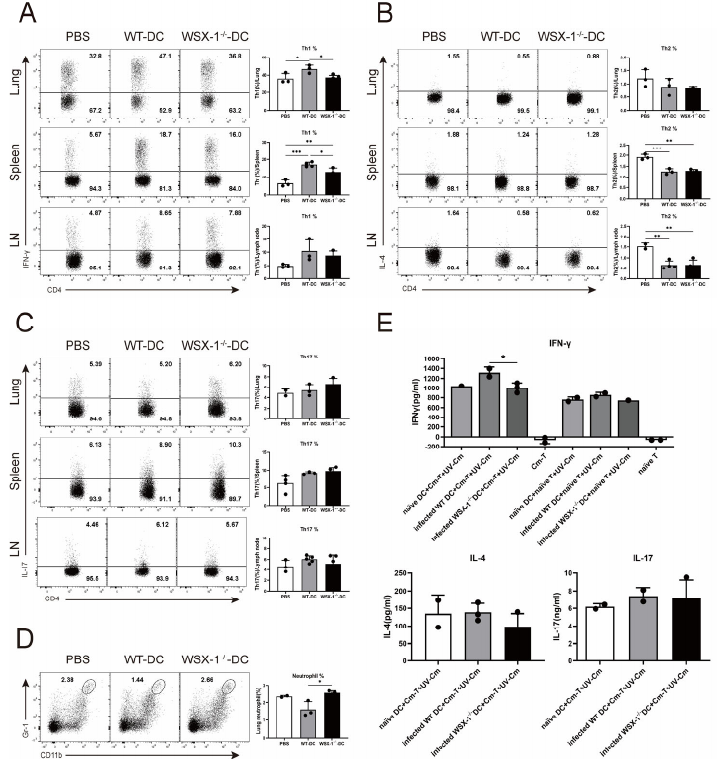
Figure 3. Th responses of recipient mice after receiving DCs in C. muridarum lung infection. The recipient mice were sacrificed on day 14 p.i. Lung, spleen, and lymph node single cells were prepared, and the Th responses were analyzed by flow cytometry and ELISA. ( A – D ) Representative flow cytometric images of IFN- γ -producing CD4 + T cells (Th1 cells, ( A )), IL-4-producing CD4 + T cells (Th2 cells, ( B )), IL-17-producing CD4 + T cells (Th17 cells, ( C )), CD11b + Ly-6G + cells (neutrophils, ( D )), and summaries of their percentages in the lung, spleen, and lymph node are shown. ( E ) Spleen DCs were sorted from naïve C57BL/6 mice, C. muridarum -infected C57BL/6 mice, and C. muridarum -infected WSX-1 -/- mice (naïve DC, infected WT-DC, and infected WSX-1 -/- -DC) by magnetic microbeads. Spleen CD4 + T cells were sorted from naïve C57BL/6 mice and C. muridarum -infected mice (naïve T and Cm-T) by magnetic microbeads. The sorted DCs and CD4 + T cells were co-cultured for 48 h in the presence or absence of UV-sterilized C. muridarum (UV-Cm). IFN- γ , IL-4, and IL-17 in the culture supernatants were determined by ELISA. Data are shown as means ± SD, representing one of three independent experiments (n = 2–5/group/experiments). Statistical significances of differences are determined by one-way ANOVA. * p < 0.05, ** p < 0.01, *** p < 0.001. Abbreviations: C. muridarum /Cm, Chlamydia muridarum ; WSX-1 -/ − , IL-27R α -deficient; p.i., post-infection; LN, lymph node; UV-Cm, UV-sterilized Chlamydia muridarum ; WT-DC, DC derived from wild-type mice; WSX-1 − / − -DC, DC derived from WSX-1 − / −